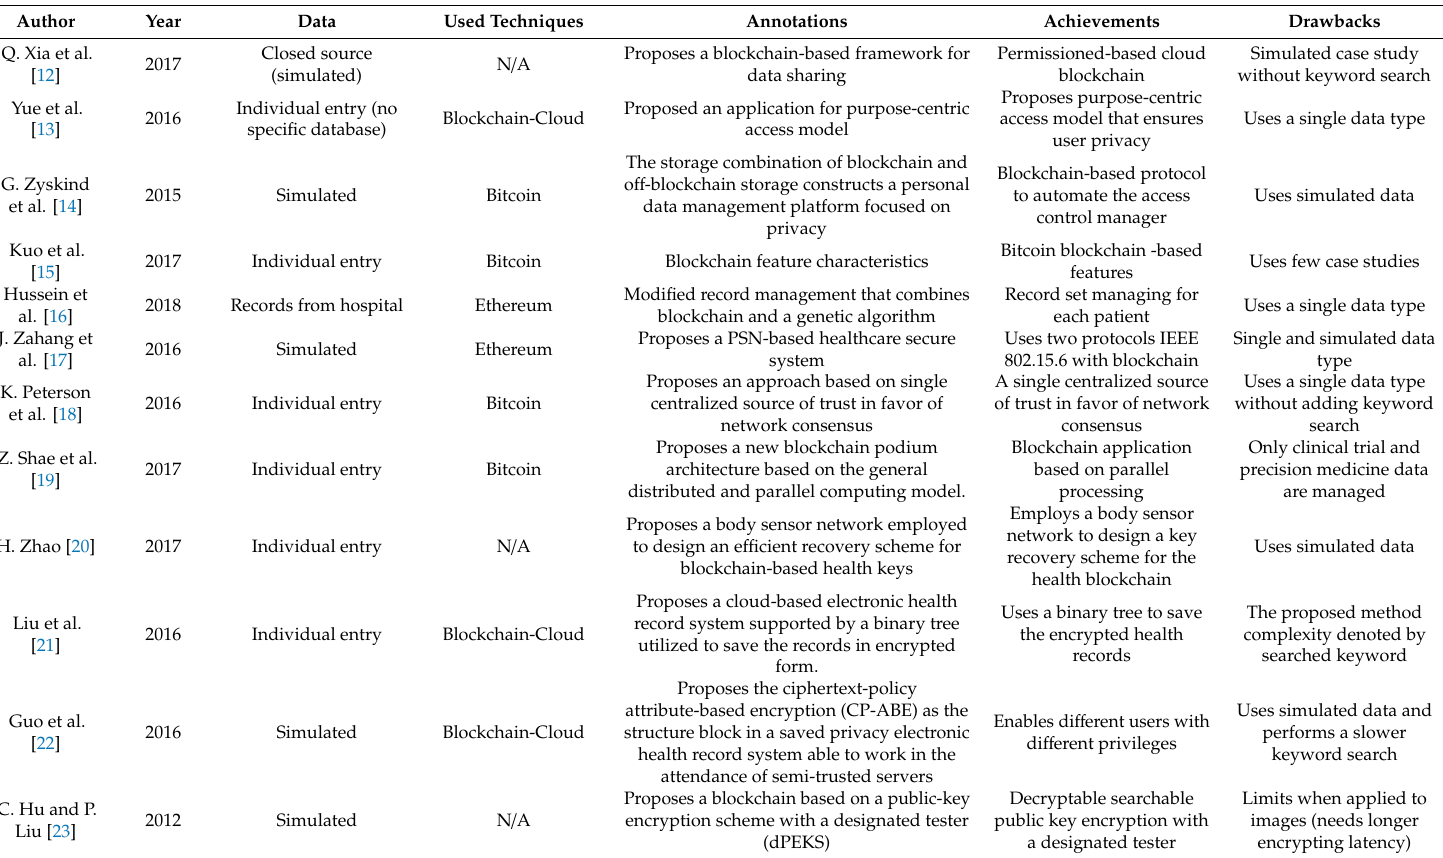
Table 1. The summary of the literature